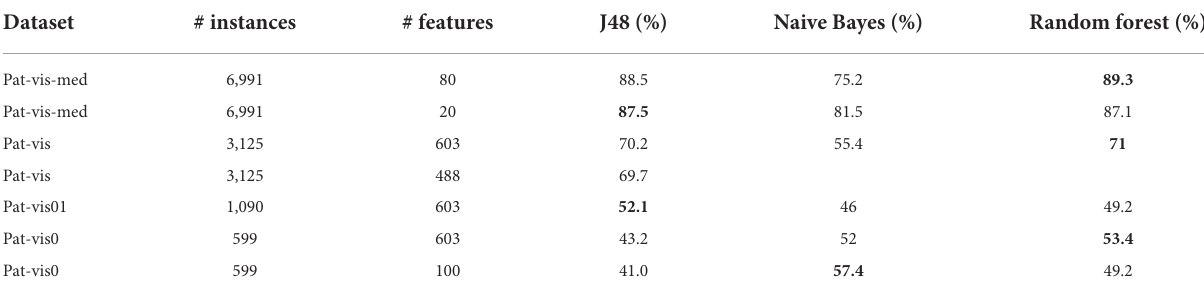
TABLE 3 Results on patient classification using WEKA using different data pre-processing, feature selection, and algorithms.